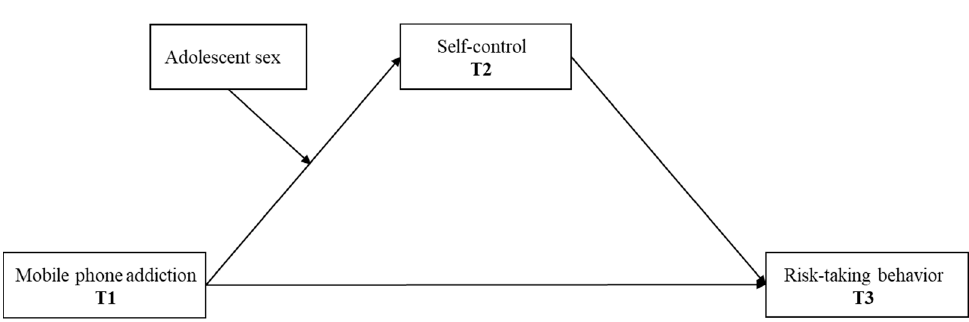
Figure 1. Conceptual moderated mediation model of the association between mobile phone addiction and risk-taking behavior; T1 = Time 1; T2 = Time 2; T3 = Time